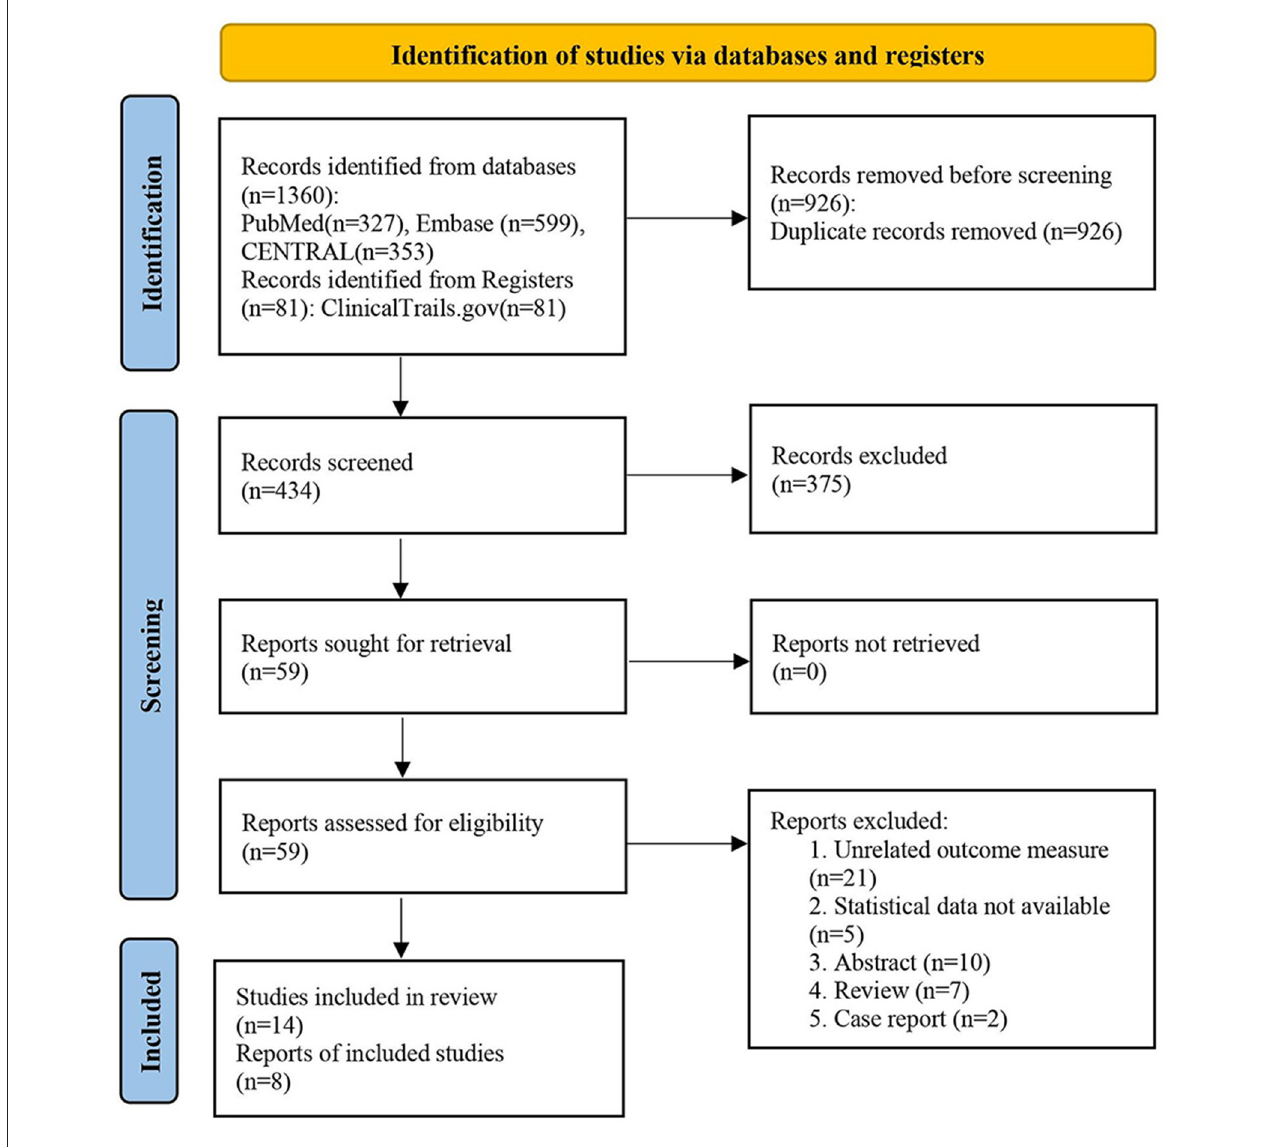
FIGURE 1 | PRISMA search strategy flow diagram of the studies selection